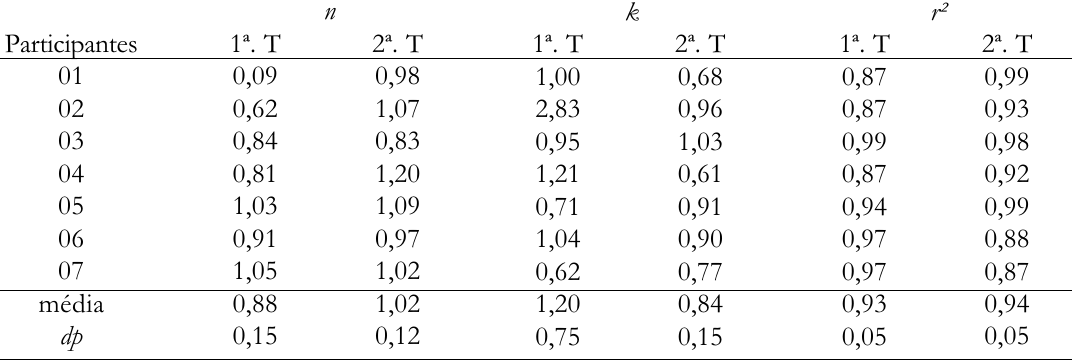
da reta ( t (12) = -3,563; p < 0,01). Para os valores do intercepto houve um efeito marginal ( t (12) = 2,689; p < 0,05). Isso indica que as crian(cid:231)as tenderam a subestimar os est(cid:237)mulos na primeira sØrie de